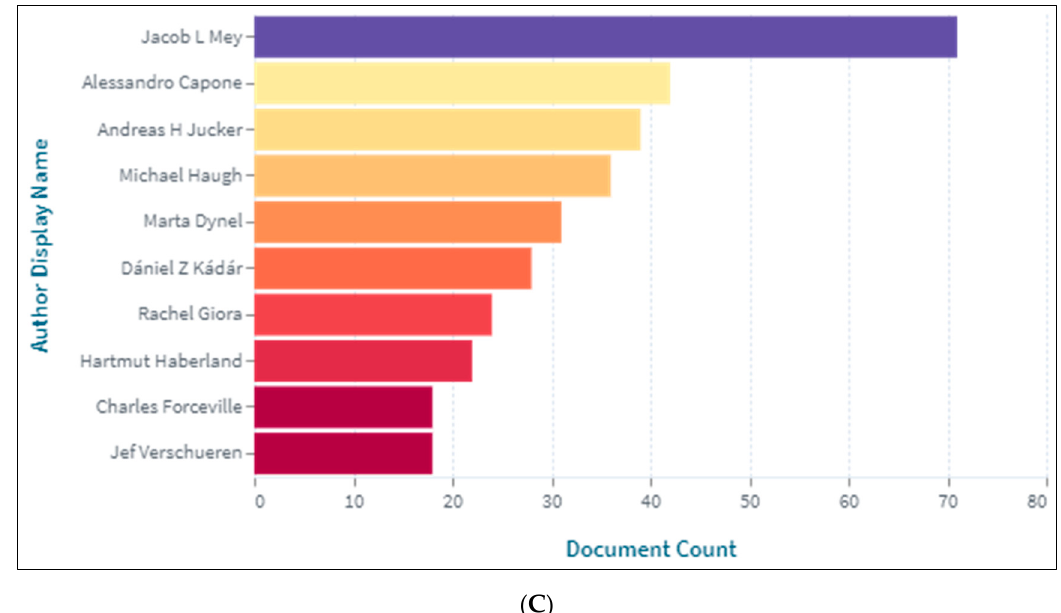
Figure 9. Pragmatics knowledge production size by author. ( A ) (Scopus). ( B ) (WOS). ( C ) (Lens). Table 3. Top cited documents of pragmatics based on citation reports from Scopus, WOS and Lens.